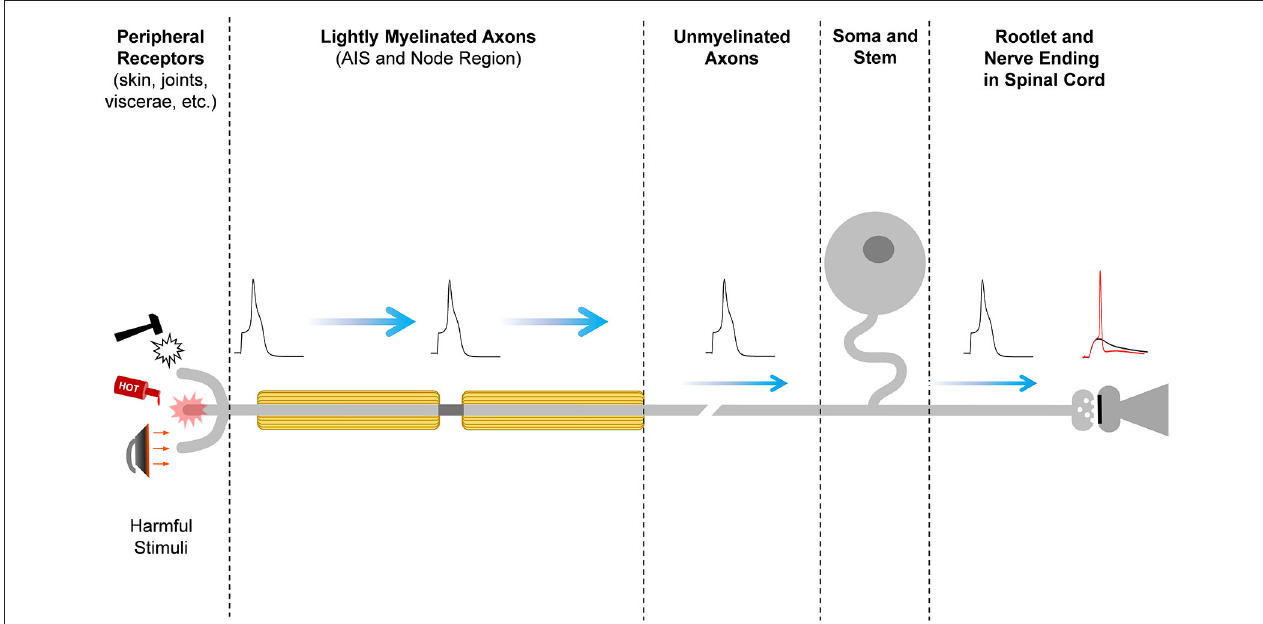
FIGURE 1 | Pain signal propagation in stereotypical nociceptive neurons of the mammalian DRG. The initiation, propagation, firing frequency, and shape of the action potential that carries nociceptive information involves a large number of diverse ion channels with heterogeneous subcellular distributions along the primary sensory neurons in the DRG. Mechanical, thermal, chemical, and inflammatory stimuli activate receptor ion channels in the periphery, giving rise to a depolarizing receptor potential that might be large enough to initiate a nerve impulse at the action potential initiation site (AIS). Firing of the action potential and the properties of the action potential waveform depend on the activities of an ensemble of voltage-gated ion channels and Ca ++ -dependent K + channels. The action potential of nociceptors propagates centrally along lightly myelinated A-delta fibers and unmyelinated C-fibers until it reaches the nerve ending in the superficial dorsal horn of the spinal cord, where it evokes Ca ++ -dependent vesicular release of the excitatory neurotransmitter glutamate. At the glutamatergic nerve ending, certain Kv channels can shape the action potential to regulate voltage-dependent Ca ++ influx into the nerve ending and, consequently, nociceptive synaptic transmission. Glutamate excites the secondary sensory neuron to relay the nociceptive information that eventually reaches pain perception centers in the